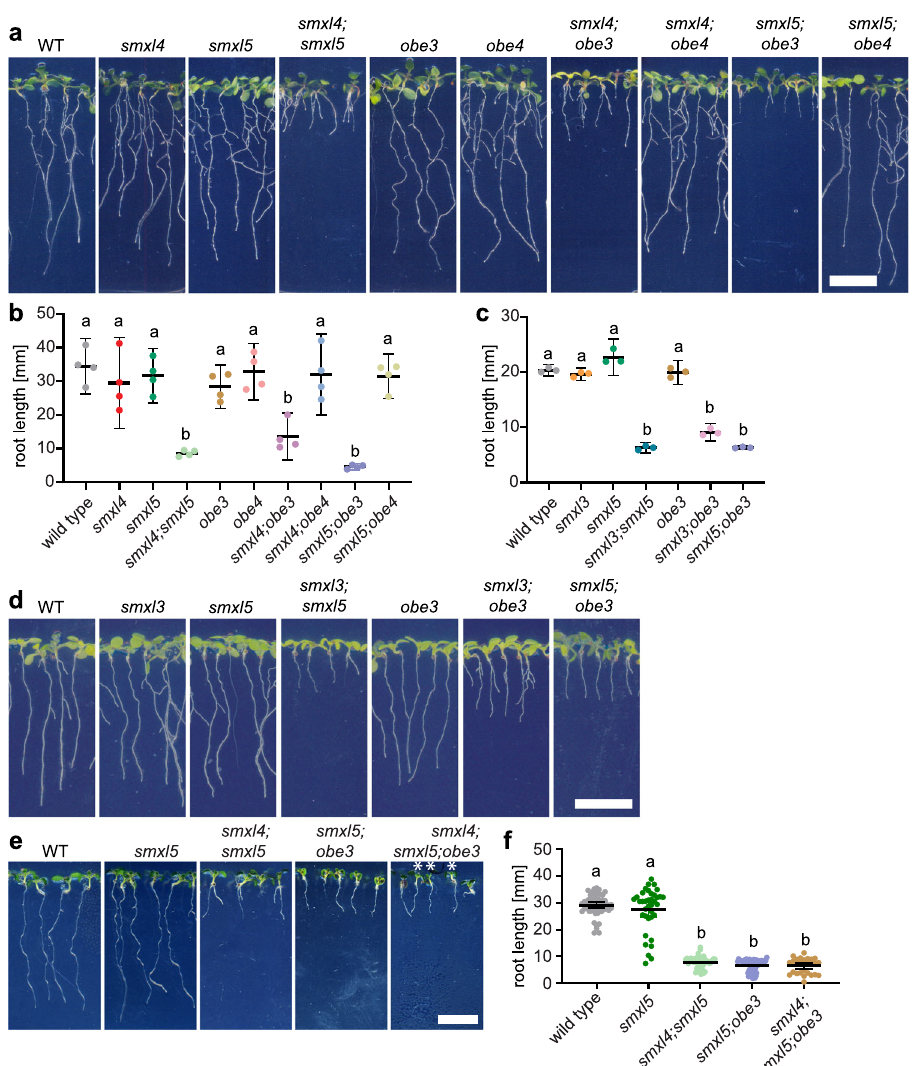
Fig. 5 | OBE3 genetically interacts with SMXL3/4/5 in root growth regulation. a Ten-day-old wild-type, smxl4, smxl5, smxl4;smxl5, obe3, obe4, smxl4;obe3, smxl4;obe4,smxl5;obe3,smxl5;obe4